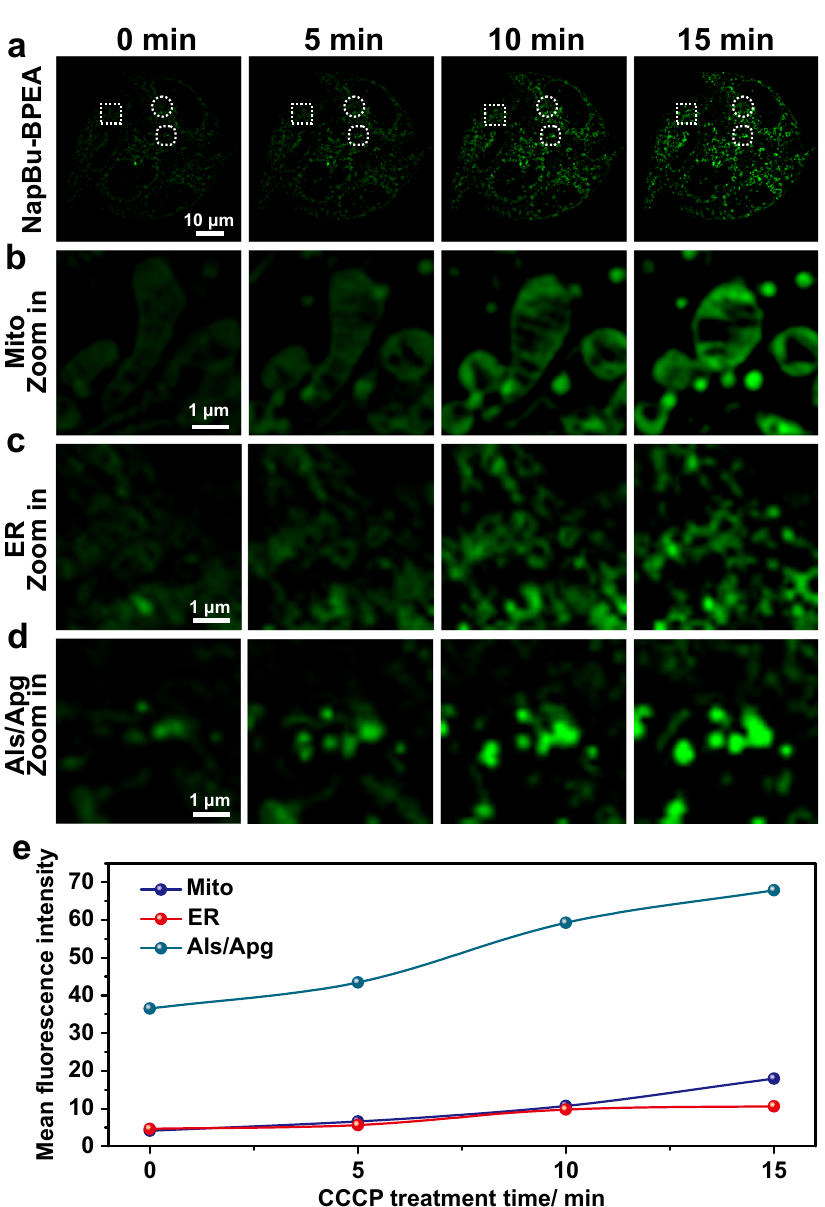
Fig. 7 NapBu-BPEA enables dynamically track of labile Zn 2 + in cells undergoing mitophagy via Zn-STIMO. a Time-lapse SIM images of HeLa cells stained by NapBu-BPEA recorded upon incubation with 20 μ M CCCP; and zoom-in images of regions of interest marked with squares ( b , mitochondria), circles ( c , ERs), and rounded squares ( d , autophagosomes/autolysosomes). e Temporal pro fi les of mean fl uorescence intensity detected for mitochondria, ERs, and autophagosomes/autolysosomes in HeLa cells showed in a – d . Scale bar: 10 μ m, enlarged images scale bar: 1 μ m. Source data are available as a Source Data fi